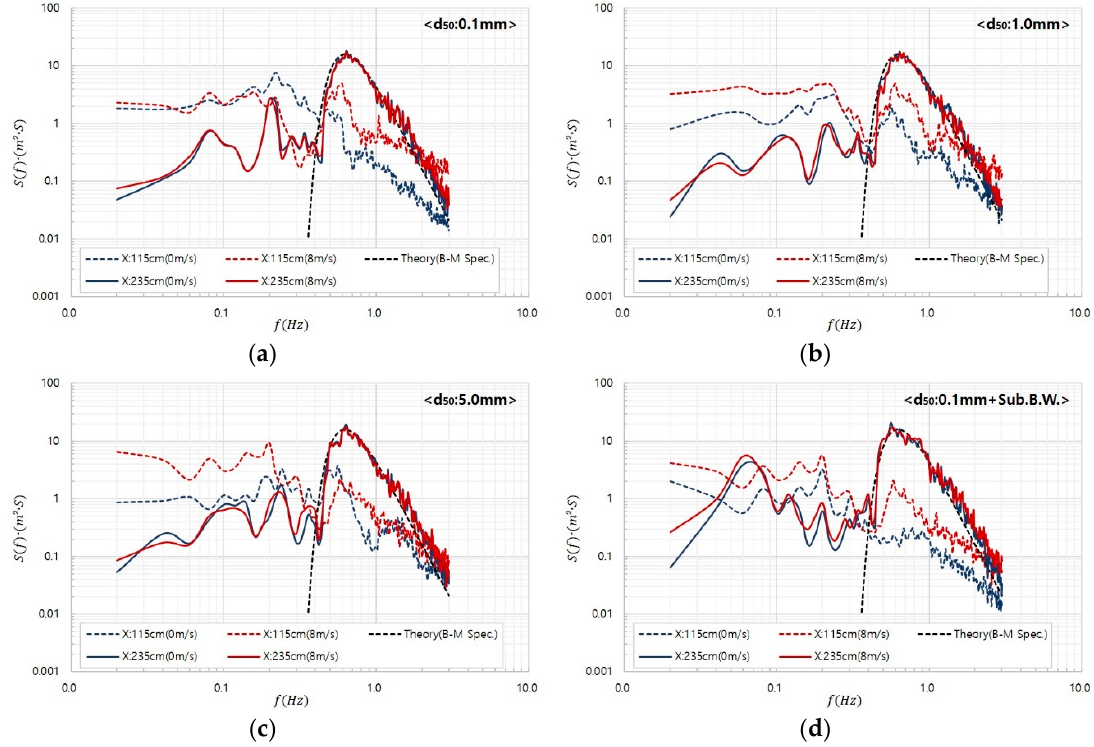
Figure 10. Wave spectrum analysis on beach profile variation. ( a ) d 50 , 0.1mm, ( b ) d 50 , 1.0 mm, ( c ) d 50 , 5.0 mm, ( d ) d 50 , 0.1mm + Sub. B.W. 5.0 mm, ( d ) d + Sub. 50 , 0.1 mm